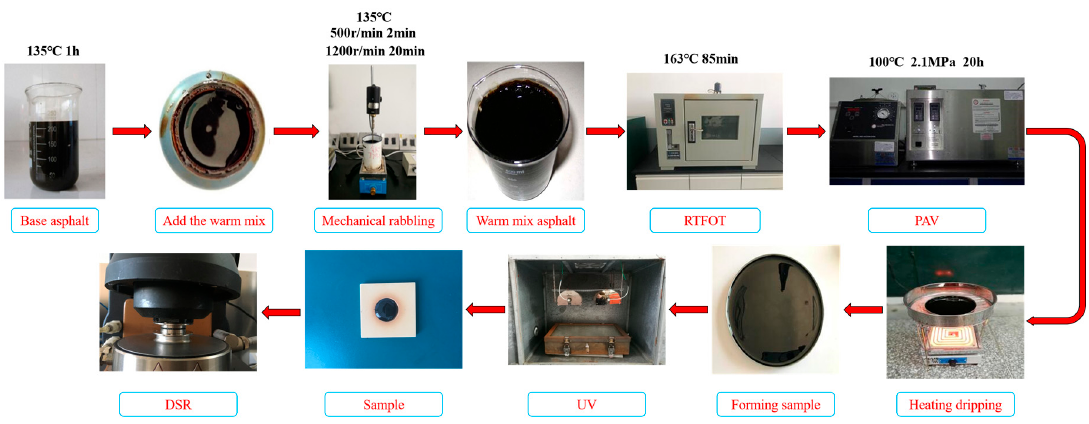
Figure 1. Flow chart of WMA preparation and test.